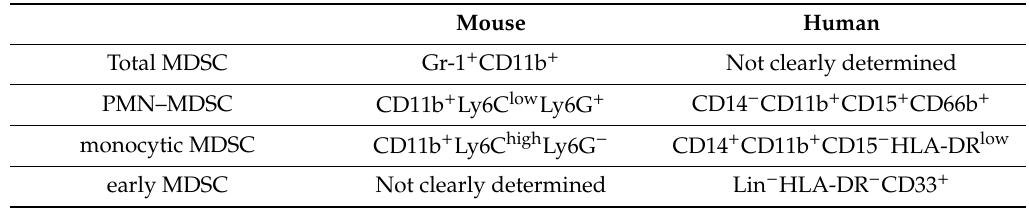
Table 2. Characteristic surface phenotypes of MDSCs.